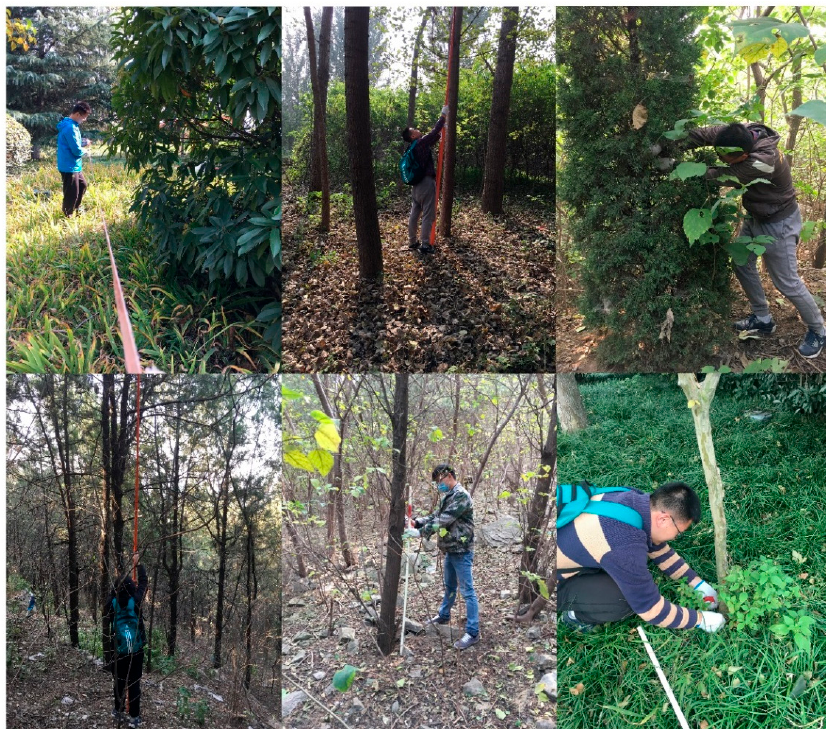
Figure 2. Photos taken in the field illustrating the measurements.